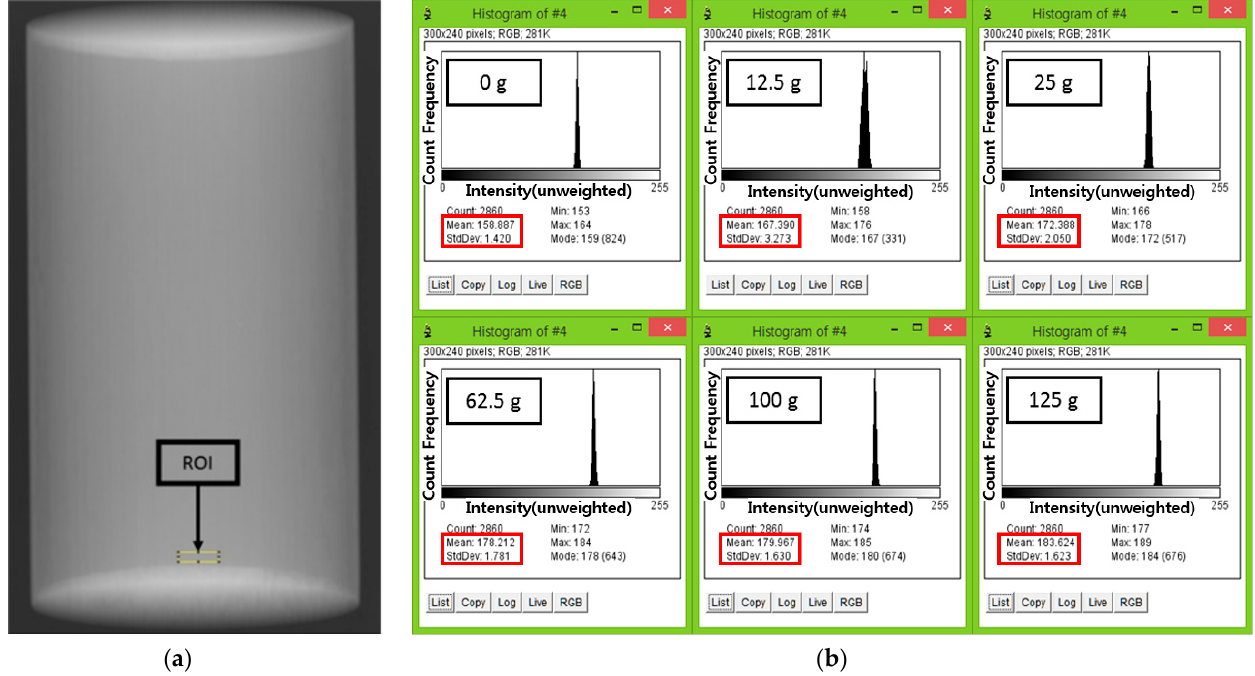
Figure 7. Images analysis using Image J as ( a ) the ROI size and position and ( b ) histograms for each accumulation condition.